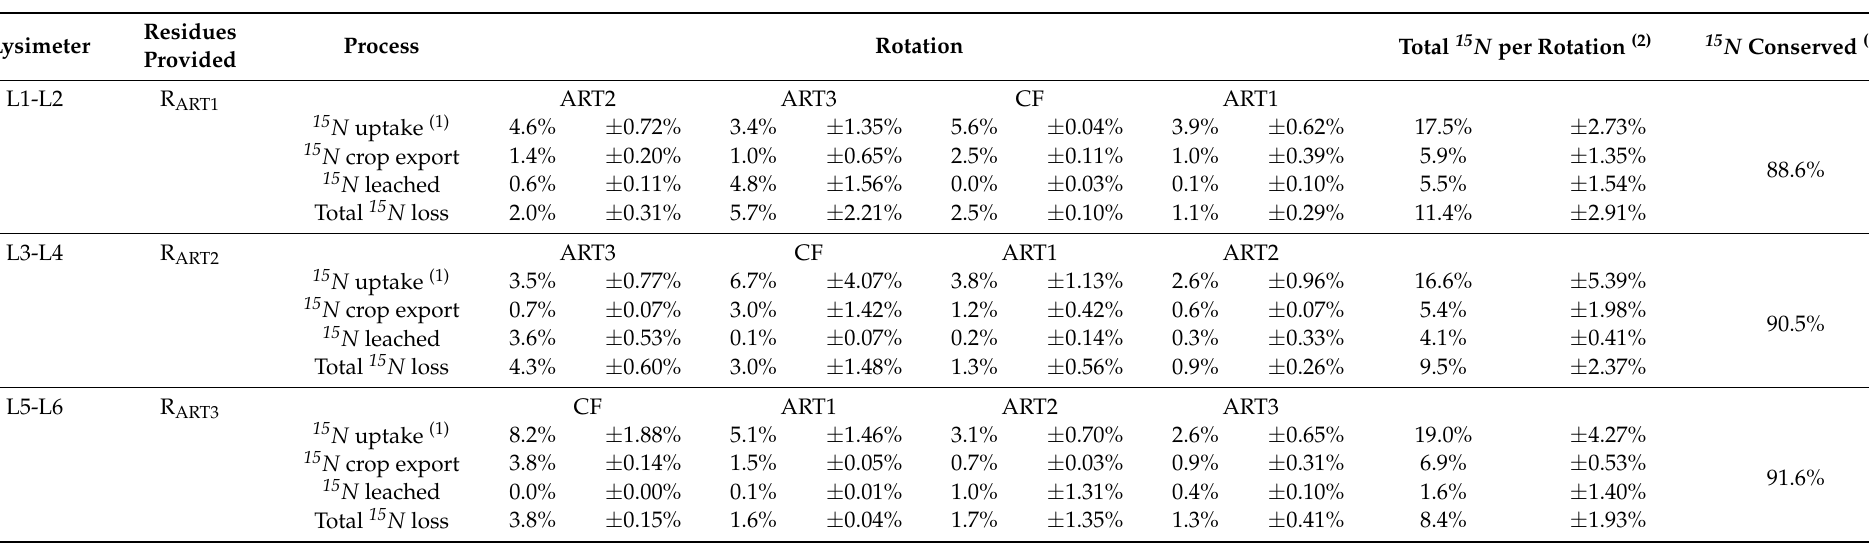
Table 5. Mean values ( ± 1 standard deviation) of artichoke (ART) and cauliflower (CF) 15 N (%) uptake, 15 N lost by nitrate leaching and 15 N exported by harvest measured from each